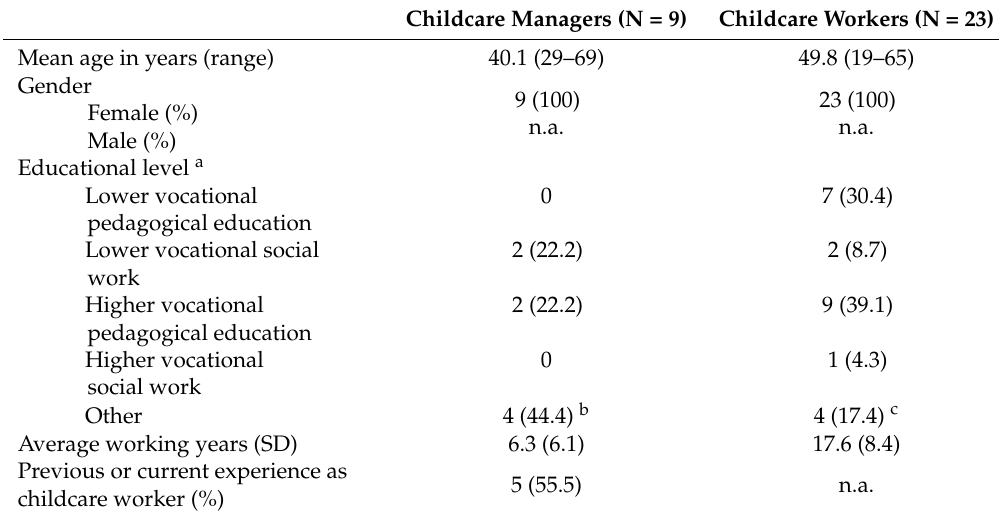
Table 1. Demographics of childcare managers and childcare